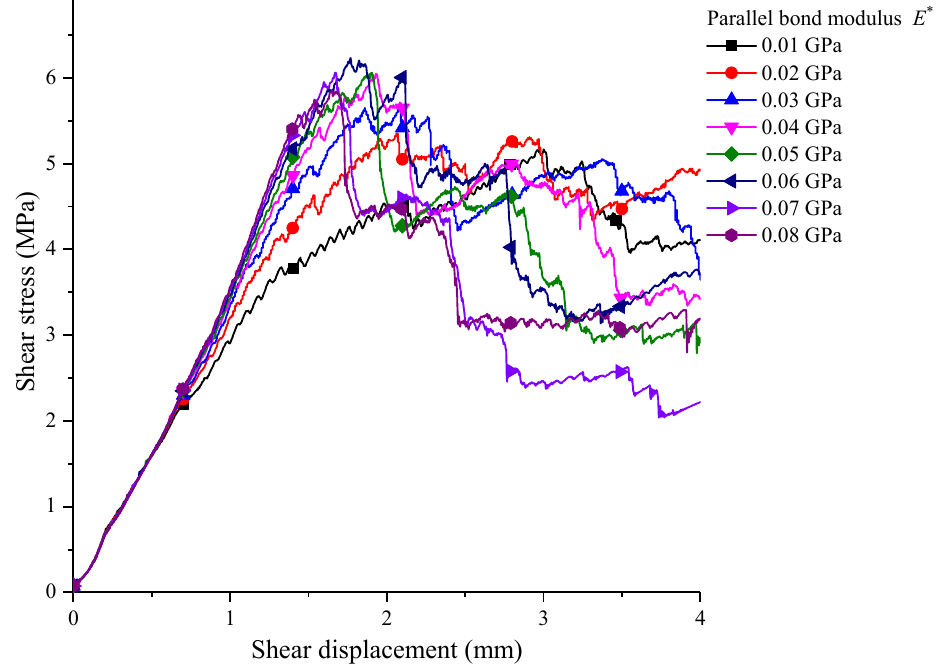
Figure 10. The corresponding shear stress–shear displacement curves with different parallel bond moduli.